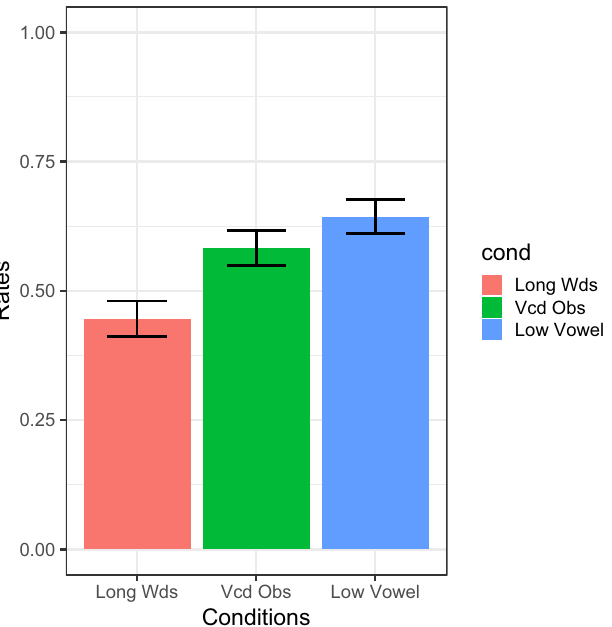
Figure 2: Rates at which the nonce words in the experimental groups were chosen as powerful spells by those familiar with the Harry Potter series ( n = 36 )